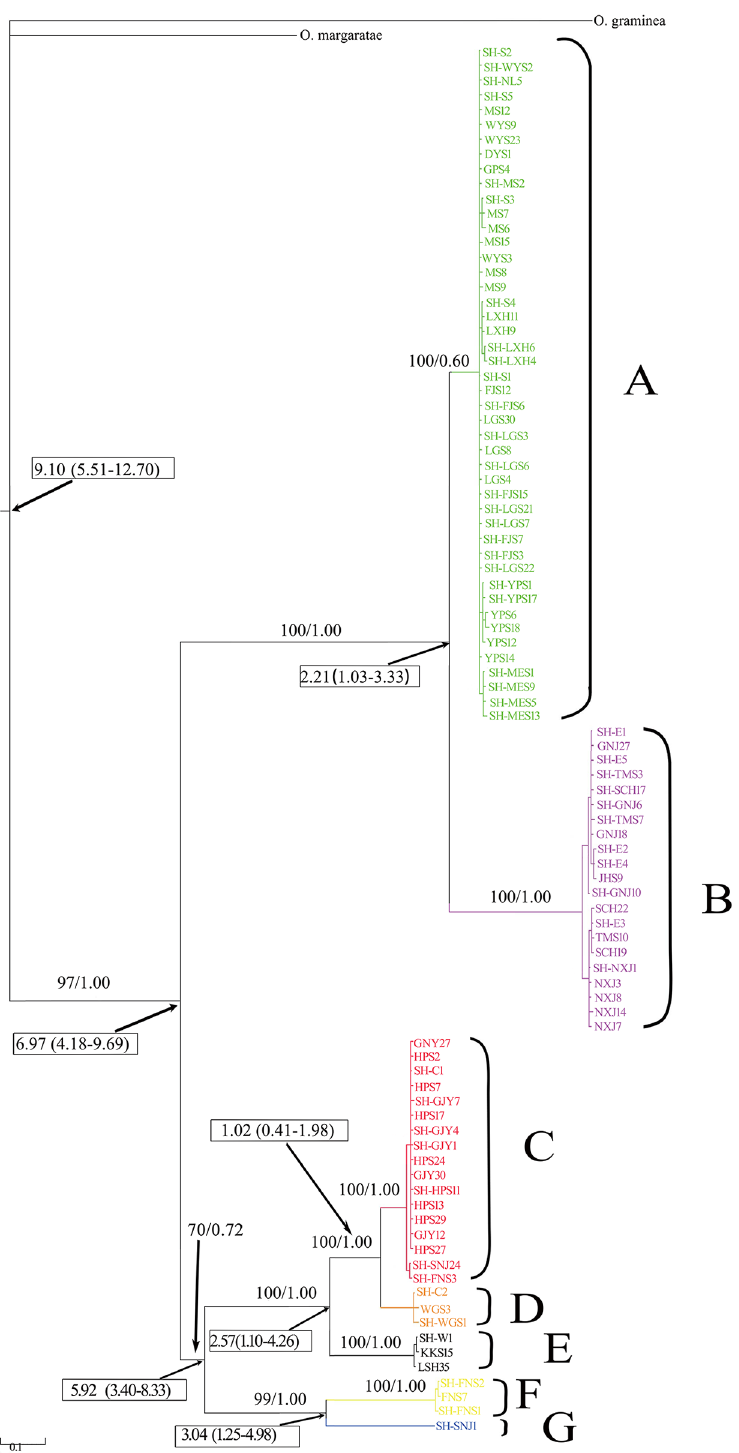
Fig 2. The Bayesian phylogenetic tree of O . schmackeri species complex based on the ND2+tRNA sequences. Numbers above branches represent Bayesian posterior probability (PP). The estimated divergence times with a 95% HPD between the major clades are given in rectangular